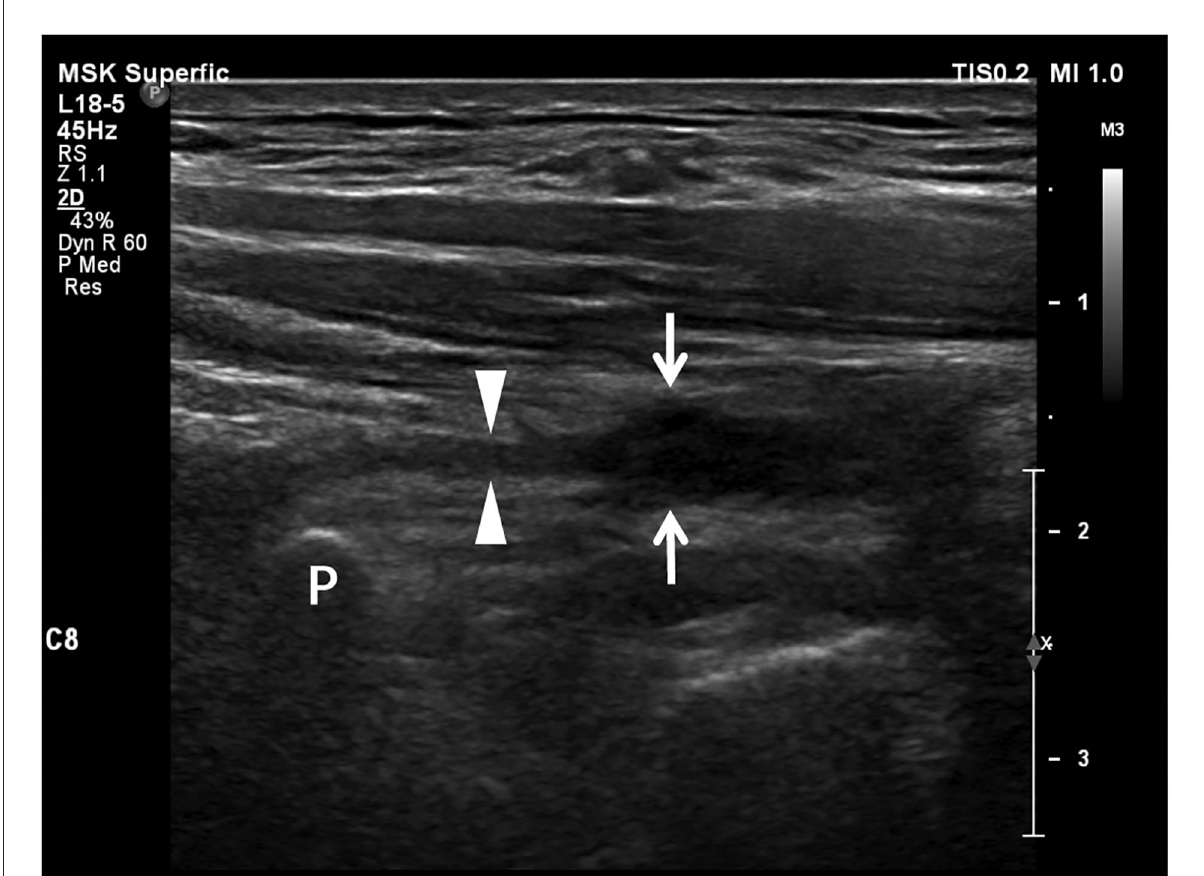
FIGURE4 Longitudinal sonogram shows a neuroma-like enlargement of a brachial plexus root. The proximal part (arrowheads) of the nerve root adjacent to the transverse process (P) appears as a thin stripe. The distal part (arrows) of the root is hypoechoic and significantly enlarged as a neuroma losing smooth contour and regularly arranged fascicles due to